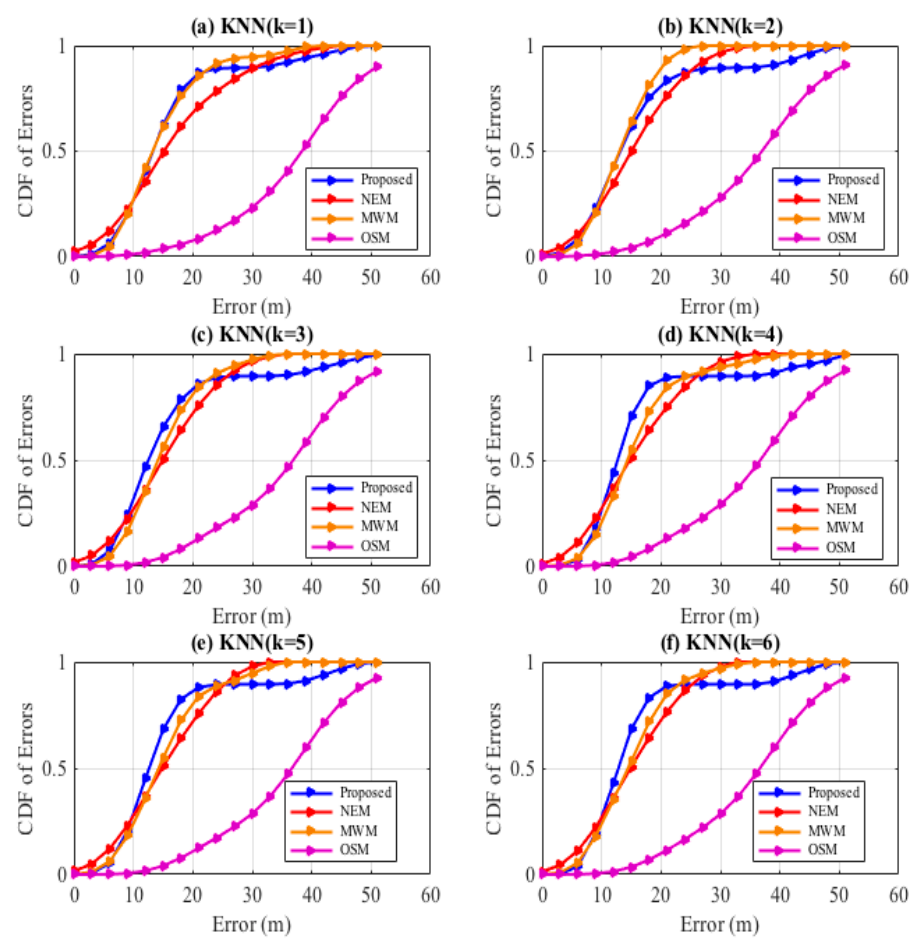
Figure 7. Localization. Comparison of the k -value with the KNN algorithm.